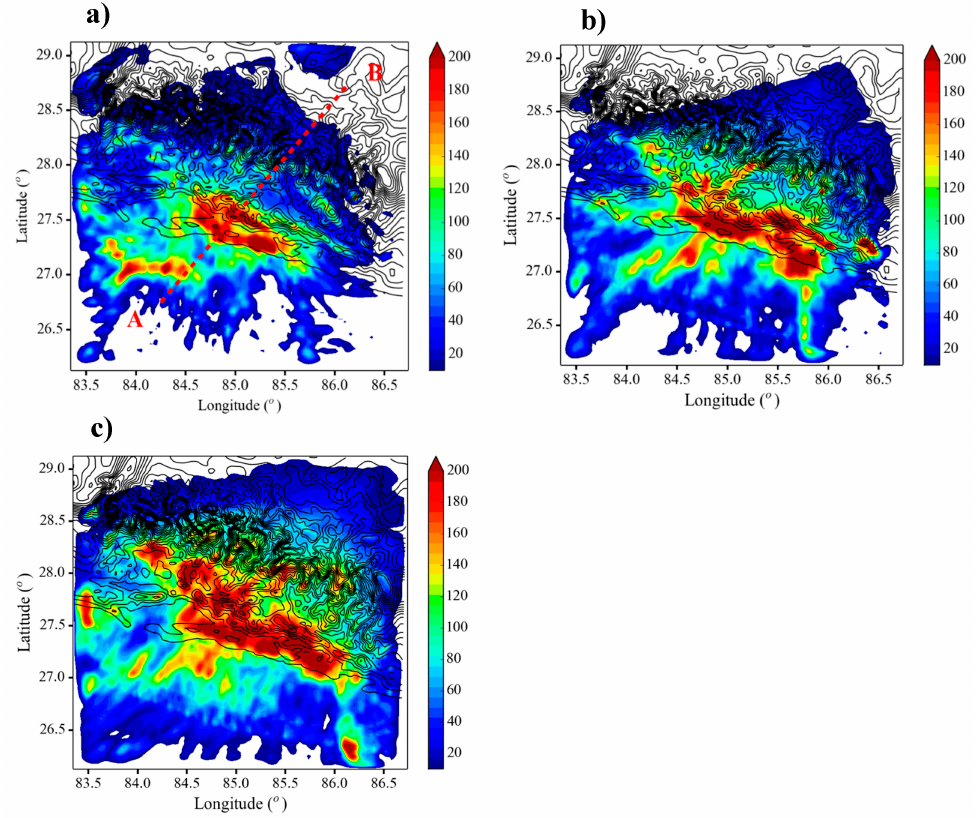
Figure 5. Spatial distribution of rainfall simulated for the ‘low’ aerosol concentration ( a ) Tctrl; ( b ) Tctrl + 5 °C; and ( c ) Tctrl + 10 °C. As explained in the text, this diagram is very similar for the ‘medium’ and ‘high’ aerosol concentrations. Elevation contours are plotted at intervals of 300 m between 300 and 6000 m